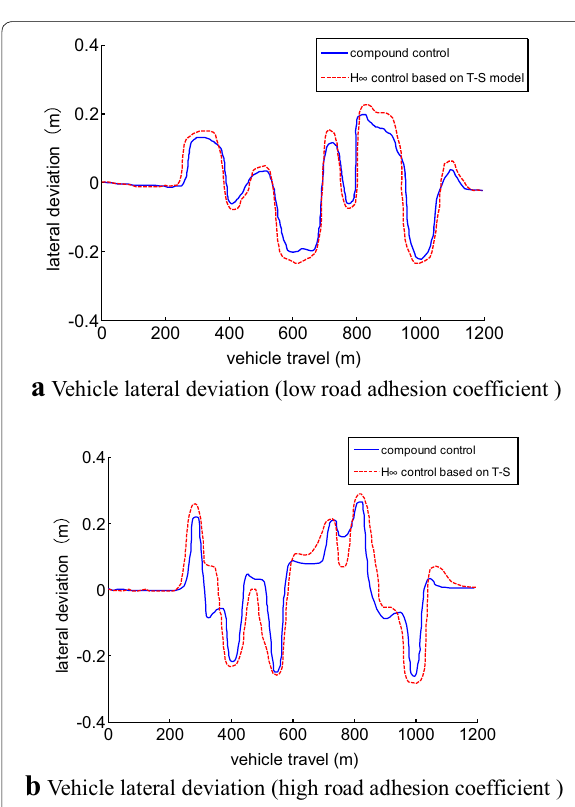
Figure 13 Vehicle driving situation for real vehicle experiment